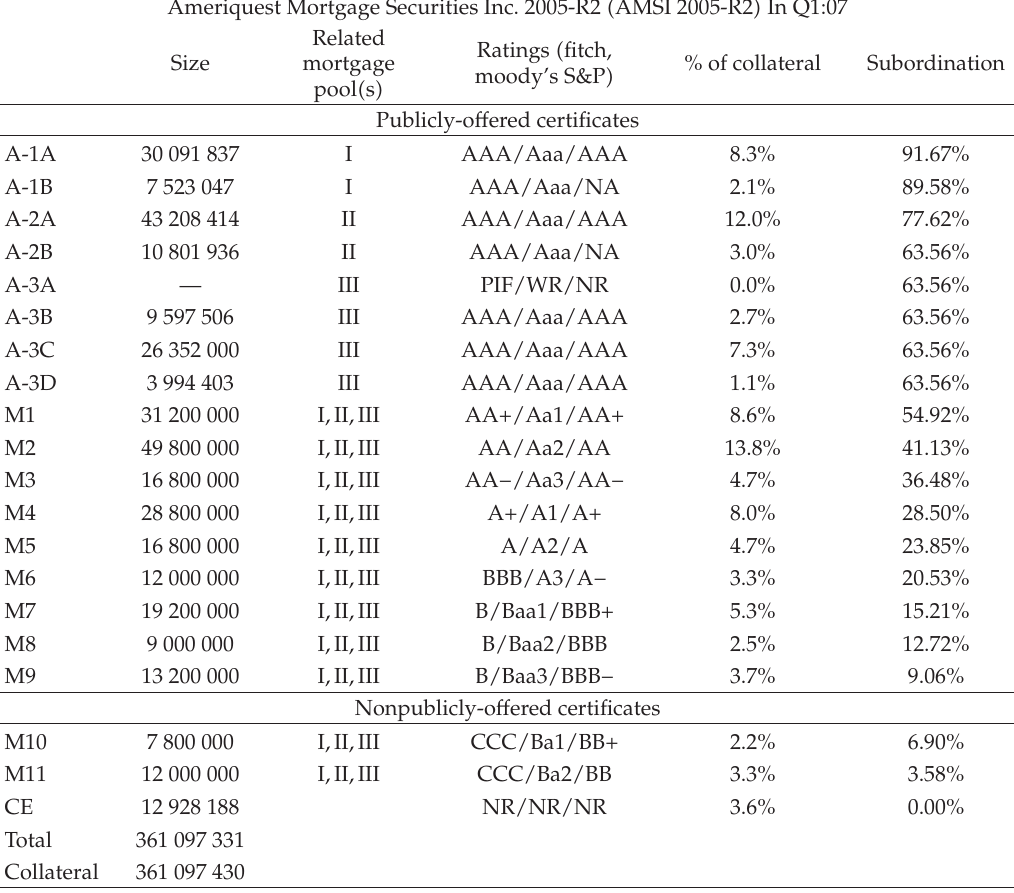
Table 9: Ameriquest Mortgage Securities Inc. 2005-R2 (cid:2) AMSI 2005-R2 (cid:3) in Q1:07; source: (cid:6) 26 (cid:7)